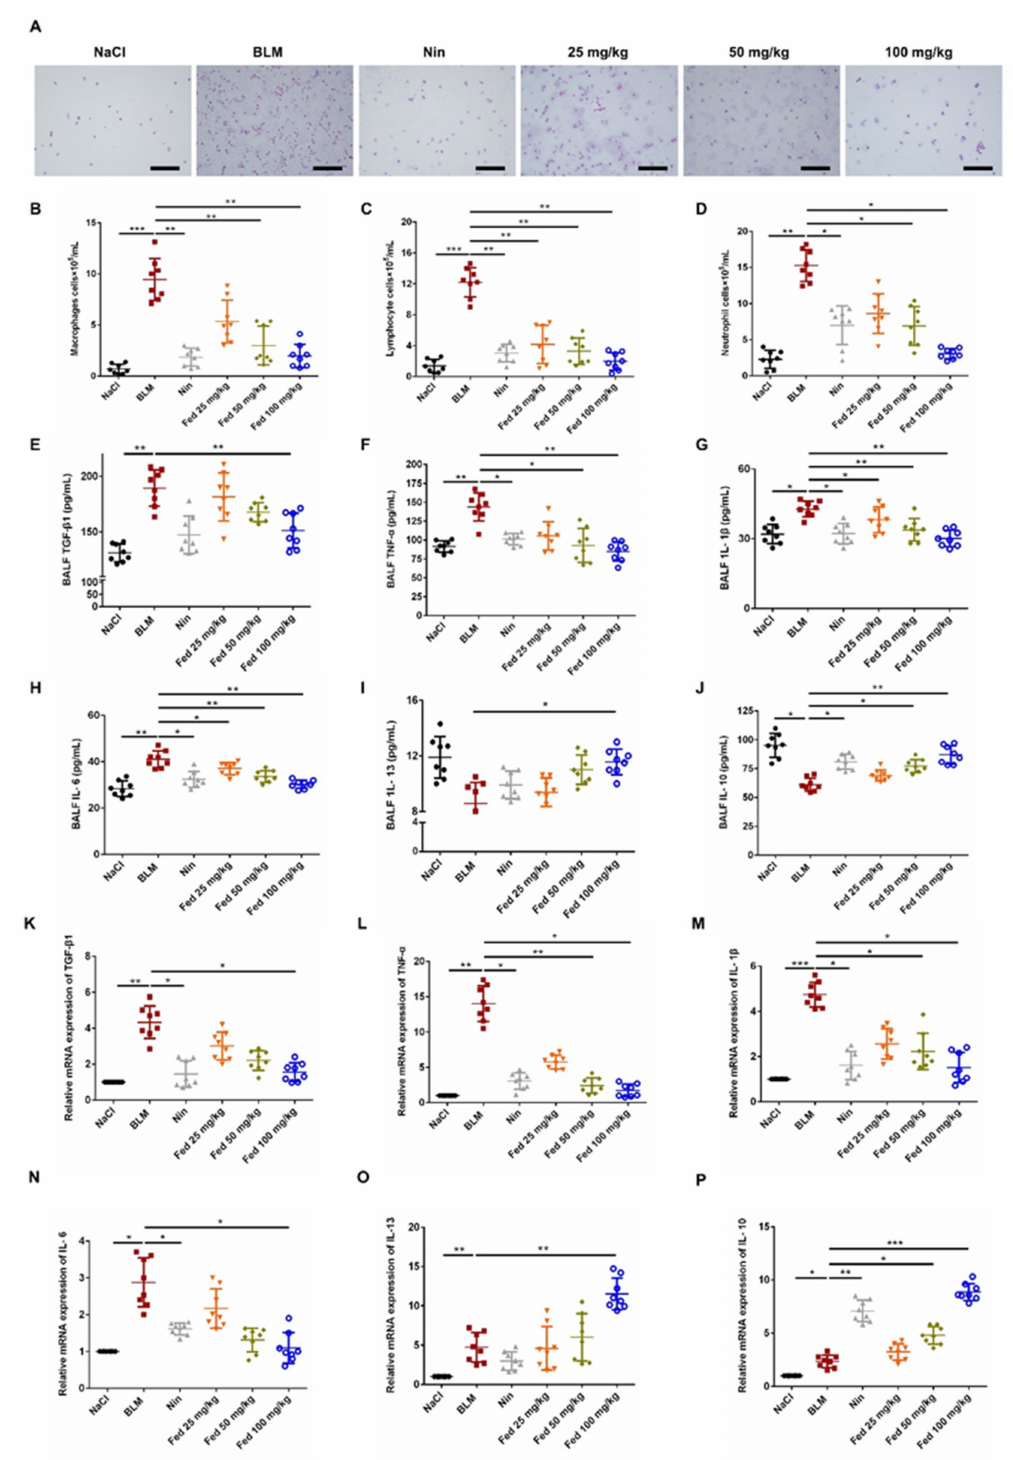
Figure 7. Influence of fedratinib on bleomycin-induced lung inflammation. ( A ) H&E staining of inflammatory cells in the BALF. Representative visual fields of H&E staining from NaCl group, BLM group, Nin group and Fed 25, 50, 100 mg/kg group, respectively. Cells were mainly macrophages, neutrophils and lymphocytes. Original magnification, × 200. ( B – D ) Macrophages, neutrophils and lymphocytes from BALF in each group were counted on day 14. ( E – J ) The expression of inflammatory factors including TGF- β 1, TNF- α , IL-1 β , IL-6, IL-13 and IL-10 in BALF were detected using an ELISA kit. ( K – P ) mRNA expression of TGF- β 1, TNF- α , IL-1 β , IL-6, IL-13 and IL-10 in the lung tissues was analyzed by real-time PCR. Data are presented as the means ± SD ( n = 8). Comparisons between groups were achieved using one-way analysis of variance (ANOVA). * p < 0.05, ** p < 0.01, *** p <